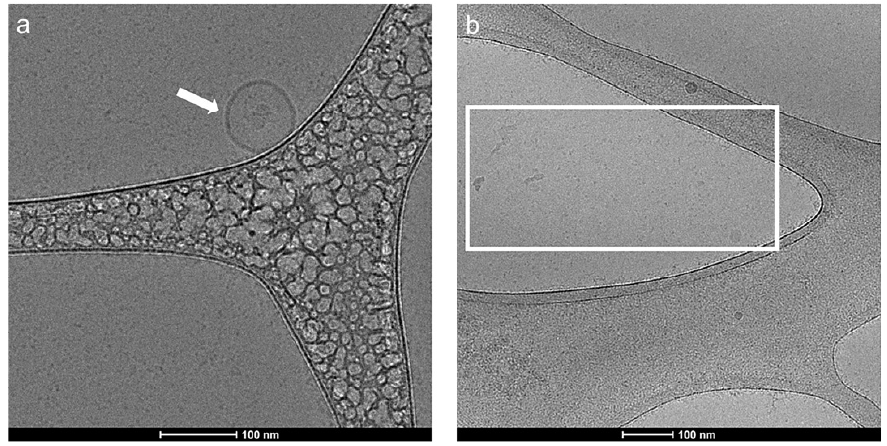
Figure 2. Electron microscopy images of exosome sample ( a ) before lysis (as indicated by the white arrow that shows an exosome) and ( b ) after lysis (as indicated in the white box whereby the vesicles have been ruptured).